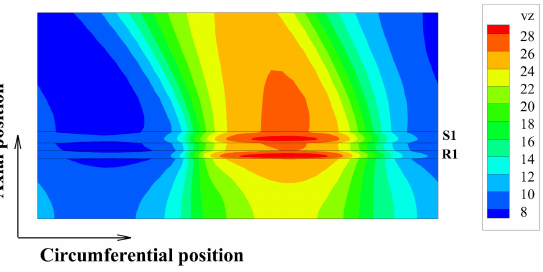
Figure 9. The axial velocity contour on unwrapped surface at midspan of the compressor. (R1: Rotor 1, S1: Stator